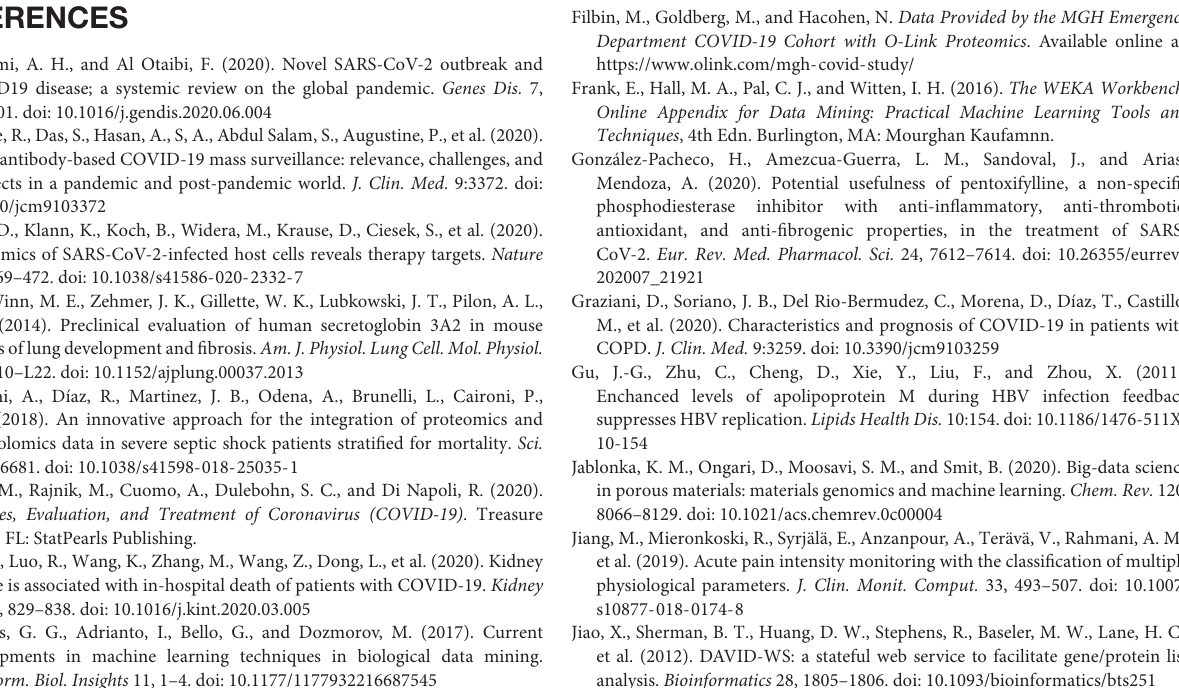
Supplementary Figure 1 | Drug–target network of the top proteins among the selected 45 proteins. Supplementary Table 1 | Clinical information or parameters used for the generation of clinical information-based models.